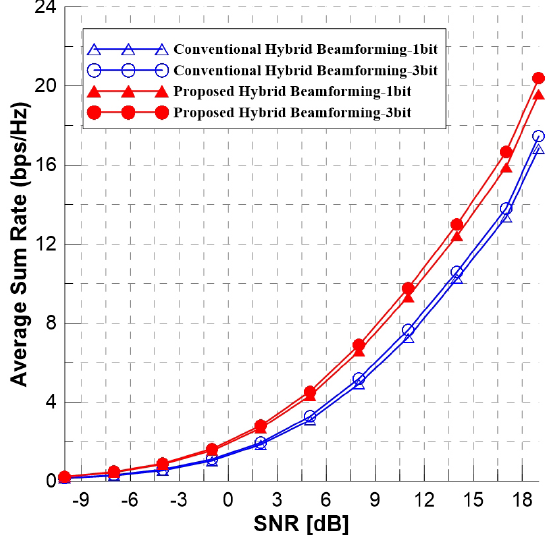
Figure 12. The average sum rate of the hybrid beamforming schemes, N t =